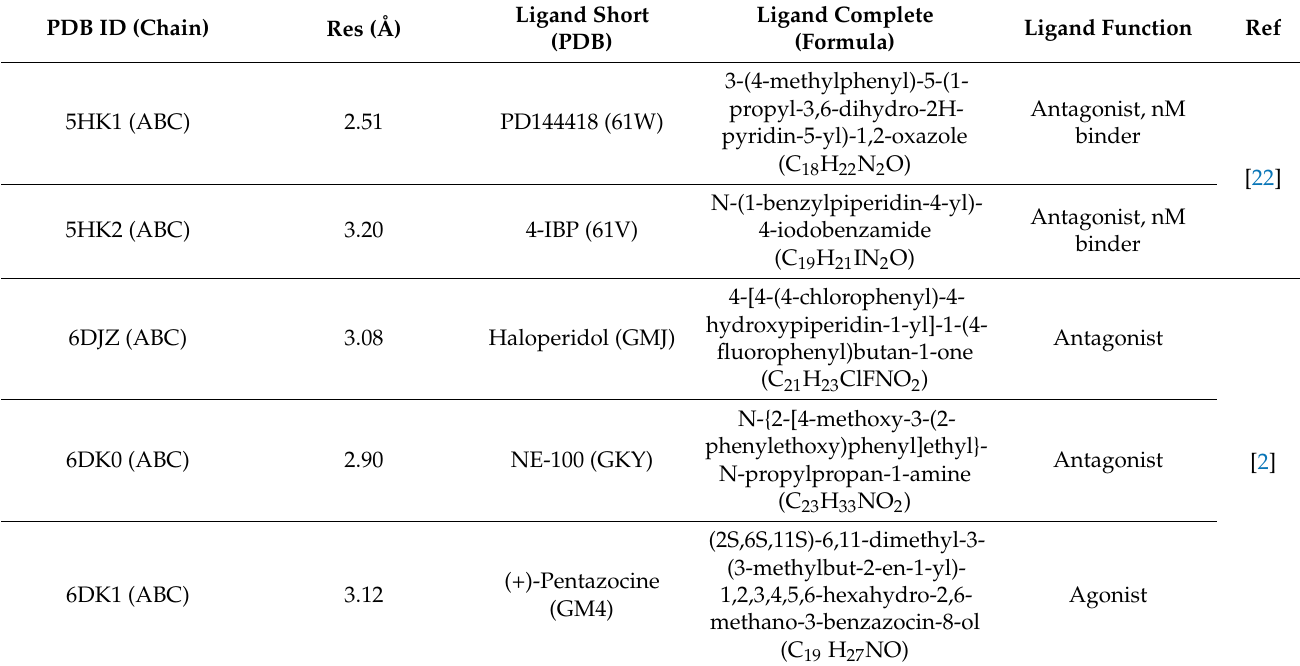
Table 1. 3D structures of σ 1R experimentally determined by X-ray crystallography and available from the PDB. PDB ID (chain), PDB identifier (name of the chains); Res, Resolution (angstroms); Ligand short (PDB): ligand short name (PDB file name); Ligand long (formula): ligand full name (chemical formula); Ligand function: agonist/antagonist activity towards σ 1R; Ref, literature